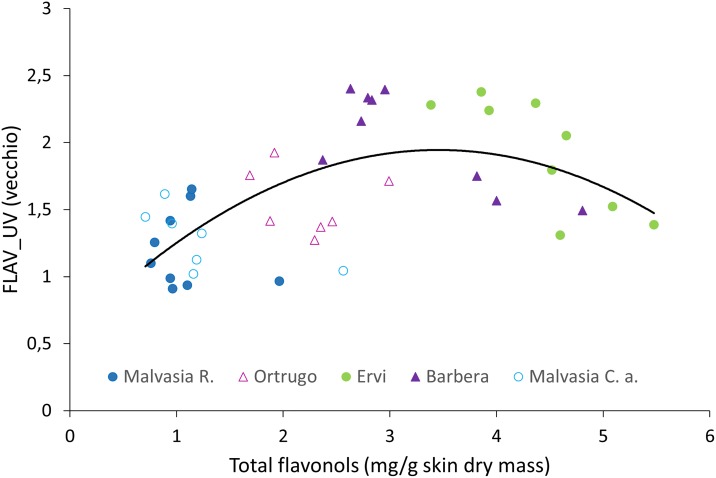
Correlation between field recorded FLAV_UV and total flavonols (mg/g dry skin mass) for data pooled over the five cultivars (n = 41).Data were fitted to the following curvilinear model: y = -0.1105x2 + 0.7613x + 0.628, R2 = 0.35 (P = 0.05). Closest fits were reached for cv. Barbera (y = -0.1331x2 + 0.5898x + 1.589, R2 = 0.66, P < 0.01, n = 9) and Ervi (-0.0886x2 + 0.2592x + 2.5412, R2 = 0.64, P < 0.01, n = 9).